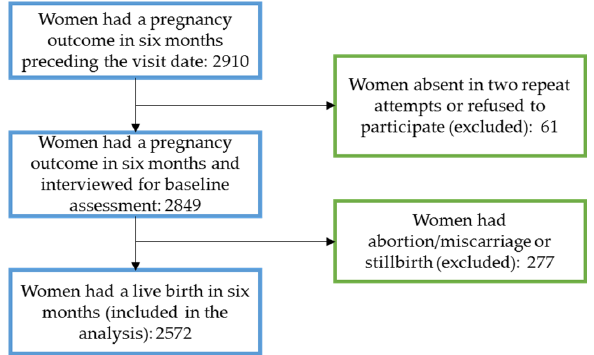
Figure 1. Participant flow diagram.